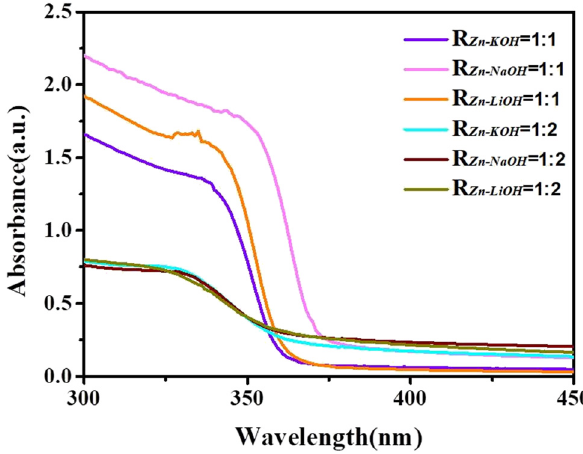
Figure 7: Ultraviolet - visible spectra of ZnO QDs synthesized under di ff erent alkali bases and di ff erent R Zn − OH